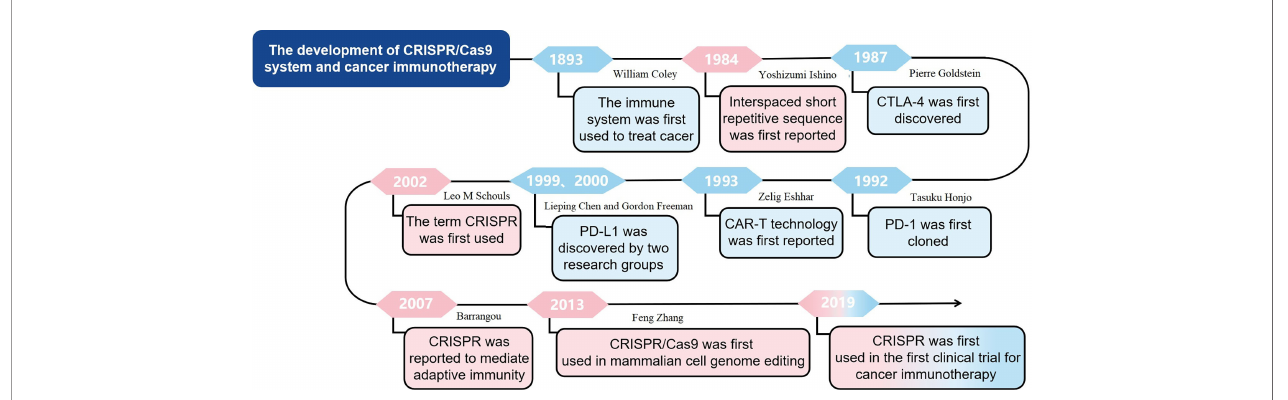
FIGURE 1 | The development of CRISPR/Cas9 system and